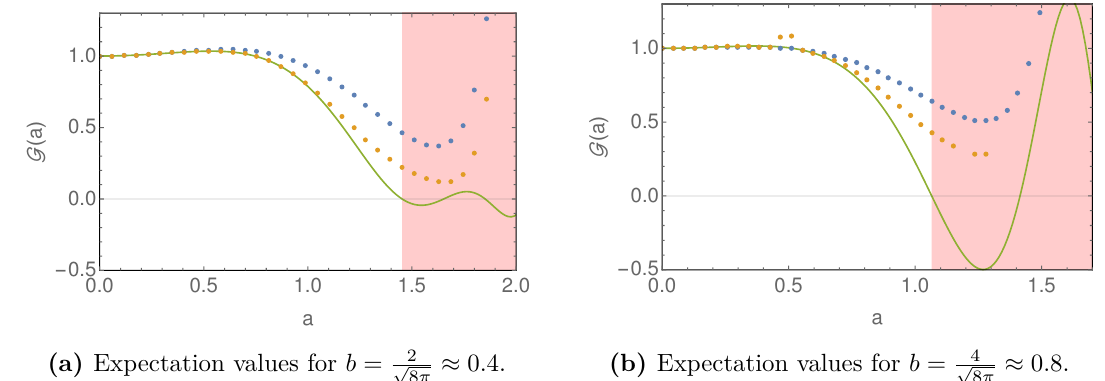
(b) Expectation values for b = 4 √ ≈ 0 . 8 . 8 π Figure 13. Vacuum expectation values for µ ShG = 0 . 1 , R = 6 . The solid green curve is predicted by the FLZZ formula. Raw TSM results are shown with blue dots, while their power-extrapolated counterparts are shown orange. The a > Q/ 2 (unphysical) domain is highlighted with red.